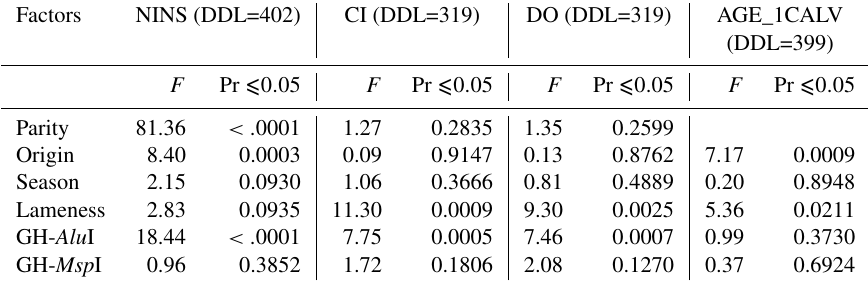
Table 4. The effect of sources of variation on reproductive traits. DDL refers to degrees of freedom, and Pr refers to probability.